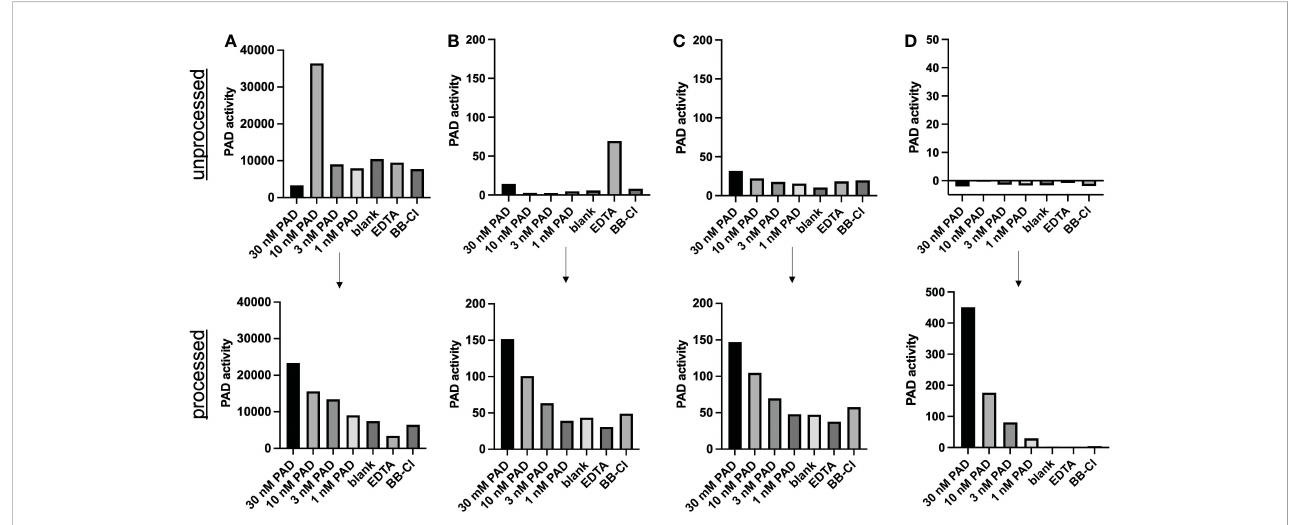
FIGURE 2 Method improvement for PAD activity detection in complex samples. PAD activity was detected through conversion of the TAMRA-(GRGA) 4 substrate after addition of (30 nM-1 nM) recombinant PAD4 to heat-inactivated synovial fl uid (A) plasma (B) , serum (C) or cell culture medium (RPMI) (D) . Unprocessed samples are shown in the top half of the fi gure (n=1). TAMRA-(GRGA) 4 substrate conversion after desalting the samples (processed) through gel fi ltration chromatography is illustrated in the lower panels of the fi gure (one representative out of 3 or more experiments is shown). A quencher concentration adjusted according to protein content and a substrate concentration of 0.5 µM were used. PAD activity was inhibited by either 3 mM EDTA or 30 µM BB-Cl-amidine (BB-Cl). PAD activity is indicated as substrate conversion measured as change in relative fl uorescence units per minute ( D